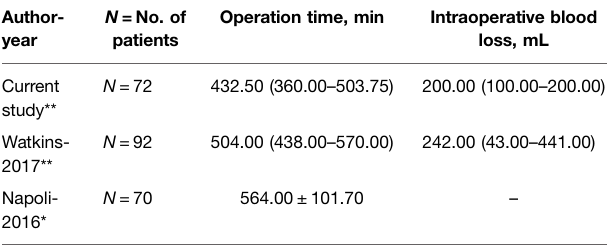
TABLE 2 | Comparison of operation outcome